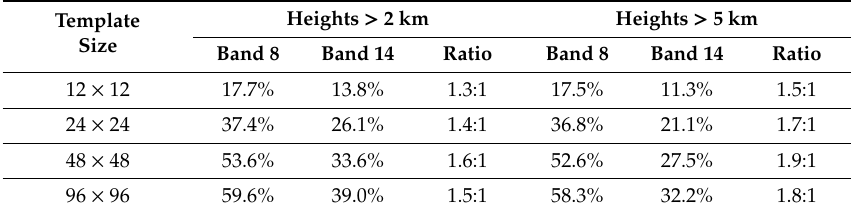
Table 4. Yield comparisons of stereo-wind retrievals in the mid- and